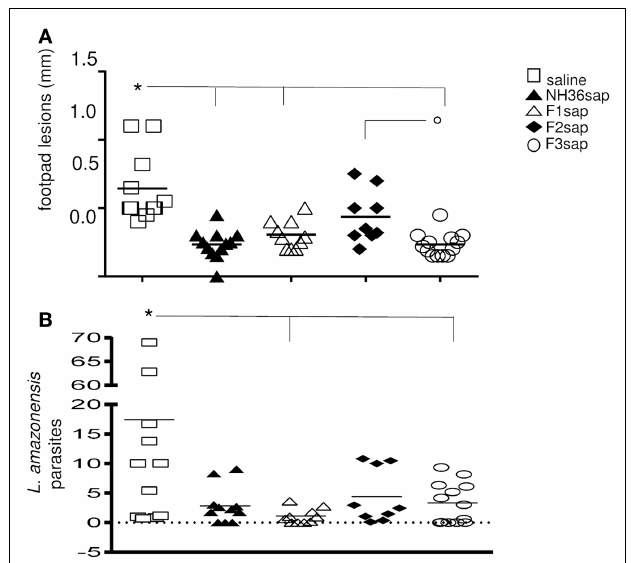
FIGURE 3 |Therapeutic effect of NH36 vaccines on L. amazonensis infection . (A) Individual sizes of footpad lesions 9weeks after infection with 10 5 infective promastigotes of L. amazonensis and further treated with NH36, F1, F2, and F3 vaccines formulated in saponin. Results represent the mean + SE of the footpad measurements of two independent experiments (six to seven animals per treatment in each experiment). * p < 0.05 different from the saline control and ◦ p < 0.05 different from the F2sap vaccine. (B) Leishmania amazonensis promastigotes in the footpad lesions as determined by RealTime PCR. *Lines indicate significant differences compared to the saline control ( p <